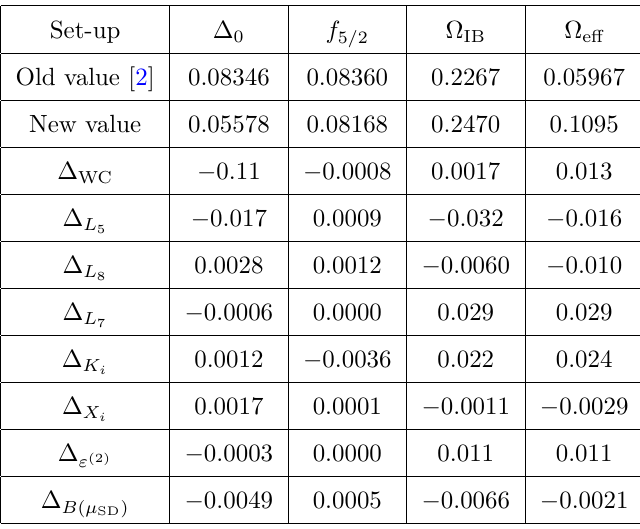
Table 12 . NLO central values for (cid:11) 6 = 0 and impact of the di(cid:11)erent modi(cid:12)ed inputs. candidates: f (1370), f (1500) and f (1710). Thus, there are two possible scenarios: 0 0 0 A : f (1370) ; K (cid:3) (1430) ; a (1450) ; f (1500) : 0 0 0 0 B